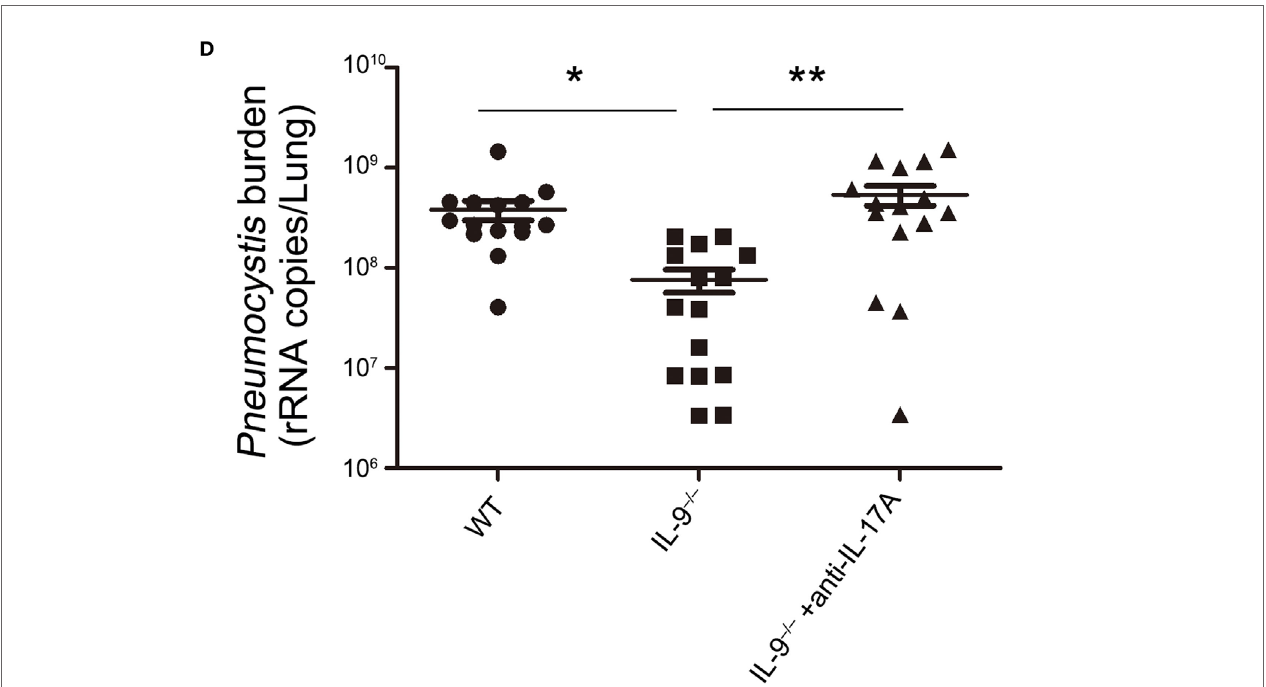
FigUre 8 | IL-17A neutralization in vivo impaired the Pneumocystis clearance in IL-9 ‒ / ‒ mice. One group of IL-9 ‒ / ‒ mice received anti-IL-17A monoclonal antibody as in Section “Materials and Methods” (IL-9 ‒ / ‒ + anti-IL-17A). At the same time, another group of IL-9 ‒ / ‒ mice (IL-9 ‒ / ‒ ) and one group of WT mice (WT) received isotype control. All of the above three groups were intratracheally injected with Pneumocystis organisms and sacrificed at 3-week postinfection. (a) The IL-17A levels were determined in plasma, bronchoalveolar lavage fluid (BALF) and lung homogenate supernatants by ELISA from the three Pneumocystis -infected mouse groups. (B) The comparison of alveolar macrophage (defined as CD45 + F4/80 + CD11b int CD11c + ) absolute number was presented from BALF of the three groups mice measured by flow cytometry. (c) The comparisons of neutrophil (defined as CD45 + CD11b + Ly-6G + ) percentage and absolute number in lung (top panel) and blood (bottom panel) were shown from the three groups of mice, which were detected by flow cytometry. Data in the graphs were represented as mean ± SEM ( n = 6 per group) and were representative of three independent experiments. (D) The Pneumocystis burden was detected by TaqMan quantitative PCR, and expressed by the copies of Pneumocystis rRNA per lung from the three groups. Data in the graph were represented as mean ± SEM of 15 mice per group from three independent experiments. One-way ANOVA test with Bonferroni postanalysis was performed to calculate statistical significance. * P < 0.05, ** P < 0.01, and *** P <